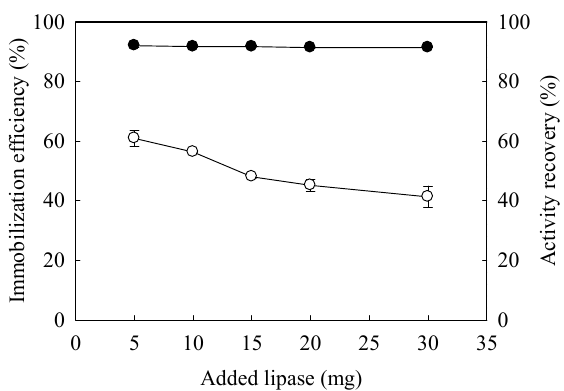
Figure 1. Effects of amount of lipase added during immobilization on immobilization efficiency ( ● ) and activity recovery ( ○ ).